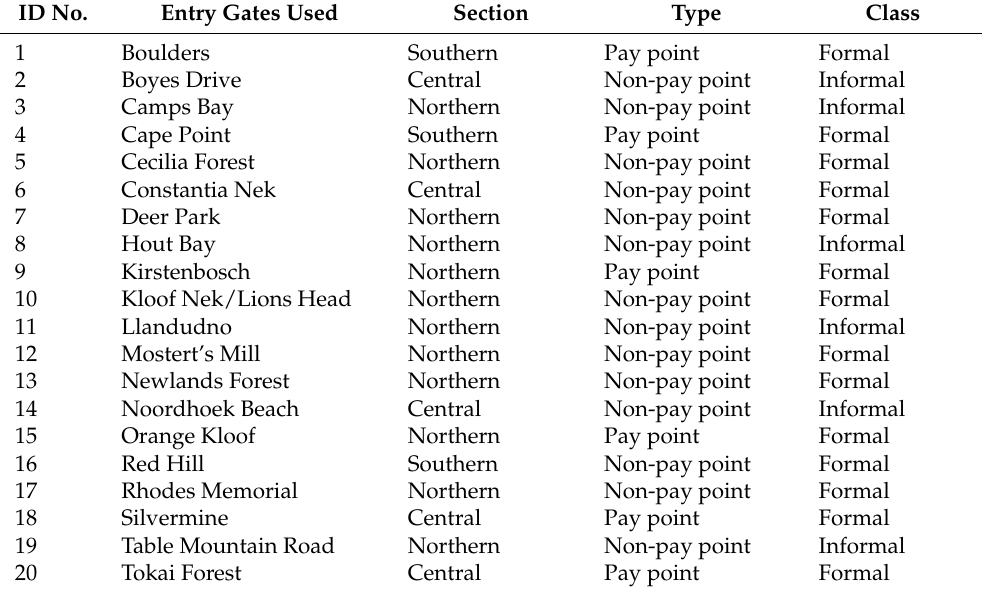
Table A2. Access points to the Table Mountain National Park listed by section, type and